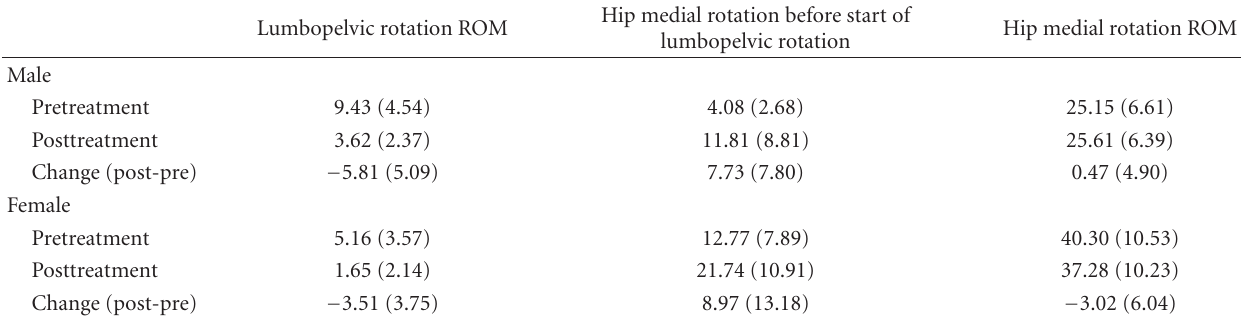
Table 2: Means (standard deviations) for transverse plane lumbopelvic and hip medial rotation movement pattern